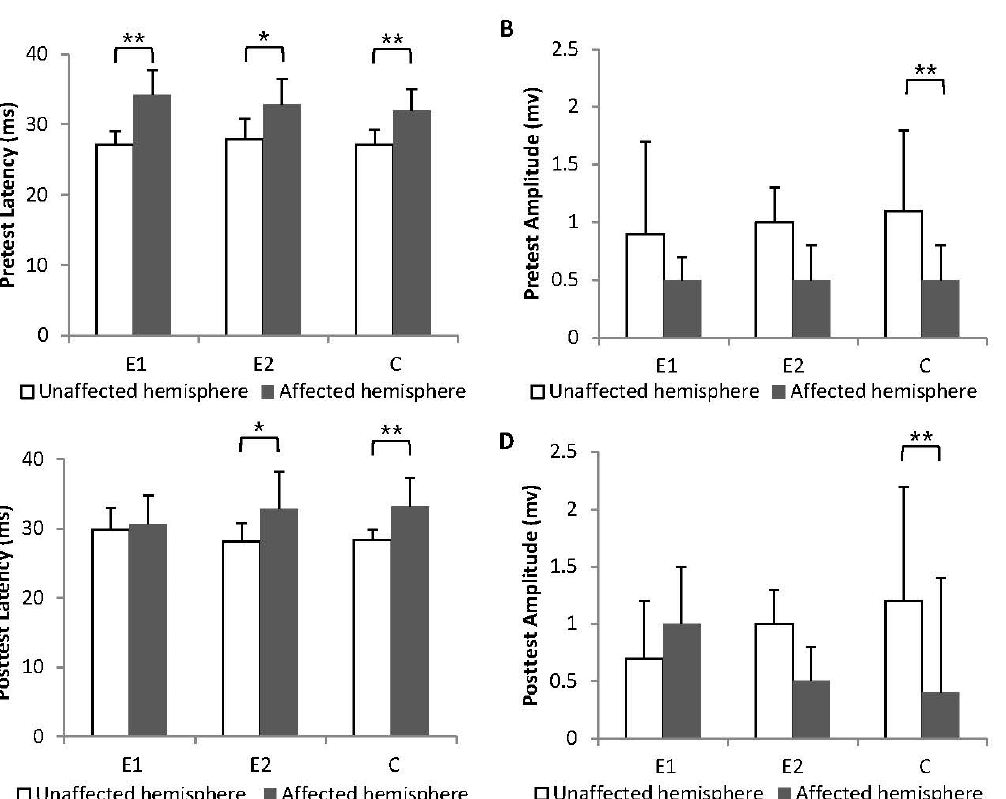
Figure 4. MEP latencies and amplitudes of unaffected and affected hemispheres. ( A ) MEP latencies of unaffected and affected hemispheres in the pretest. ( B ) MEP amplitudes of unaffected and affected hemispheres in the pretest. ( C ) MEP latencies of unaffected and affected hemispheres in the posttest. ( D ) MEP amplitudes of unaffected and affected hemispheres in the posttest. Error bars represent the standard deviation of the mean. * p < 0.05, ** p <